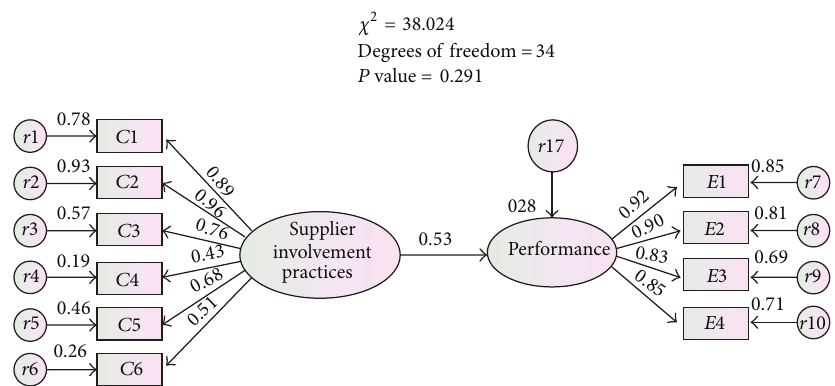
Figure 2: Shows the results of SEM. Note: results are depicted in standardized